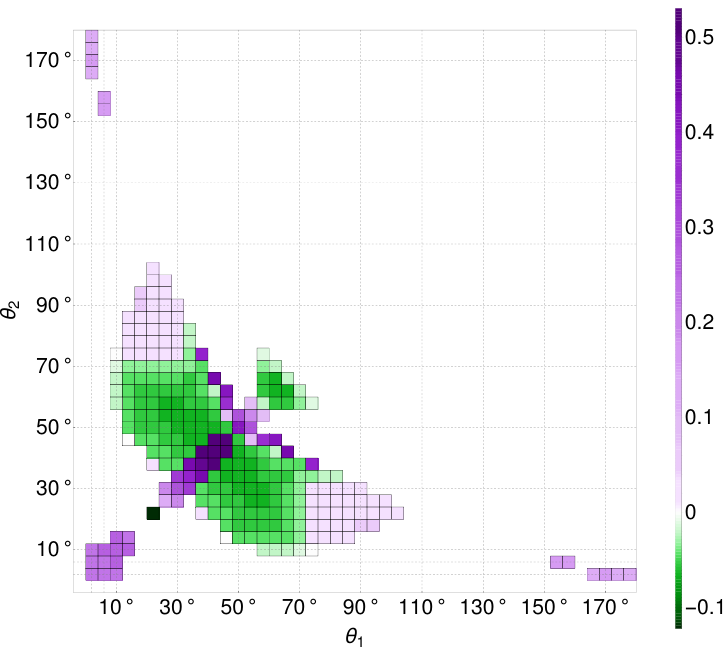
Figure 4: The distribution of ∆ SIGS for the deuteron breakup at E = 65 MeV.